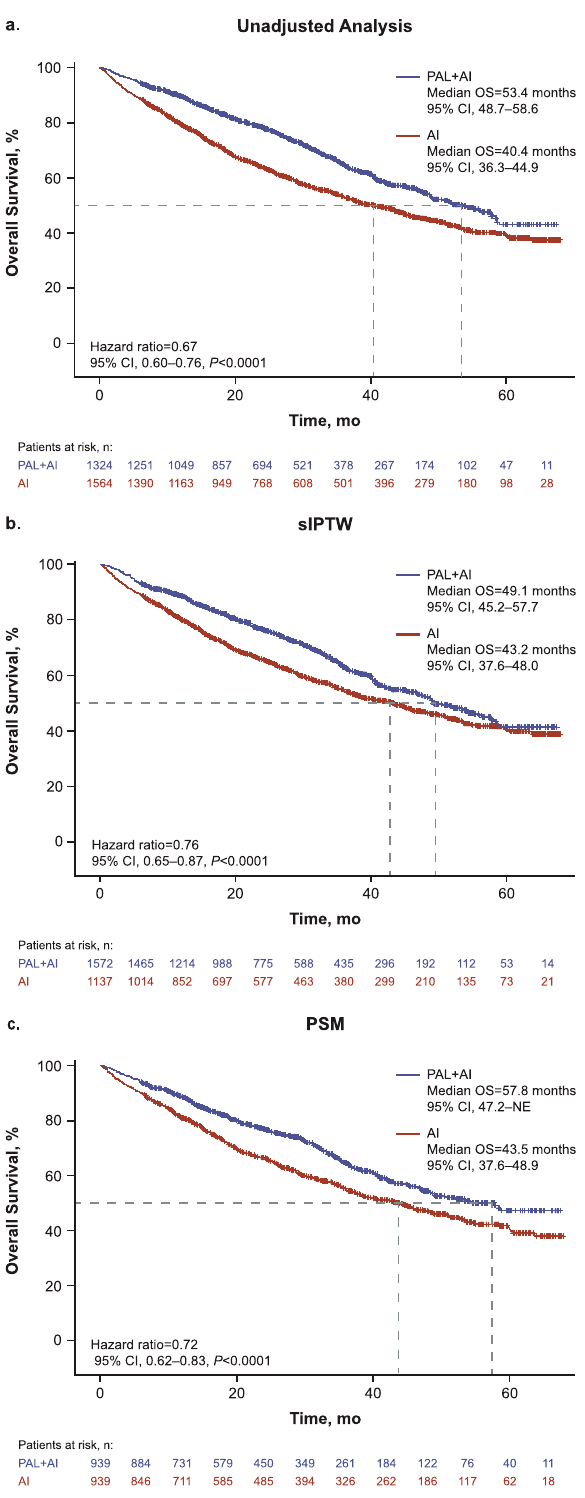
Fig. 2 Kaplan – Meier curves of overall survival. AI aromatase inhibitor; NE not estimable; OS overall survival; PAL palbociclib; PSM propensity score matching; sIPTW stabilized inverse prob- ability of treatment weighting. Statistical signi fi cance was analyzed by a weighted Cox proportional hazards